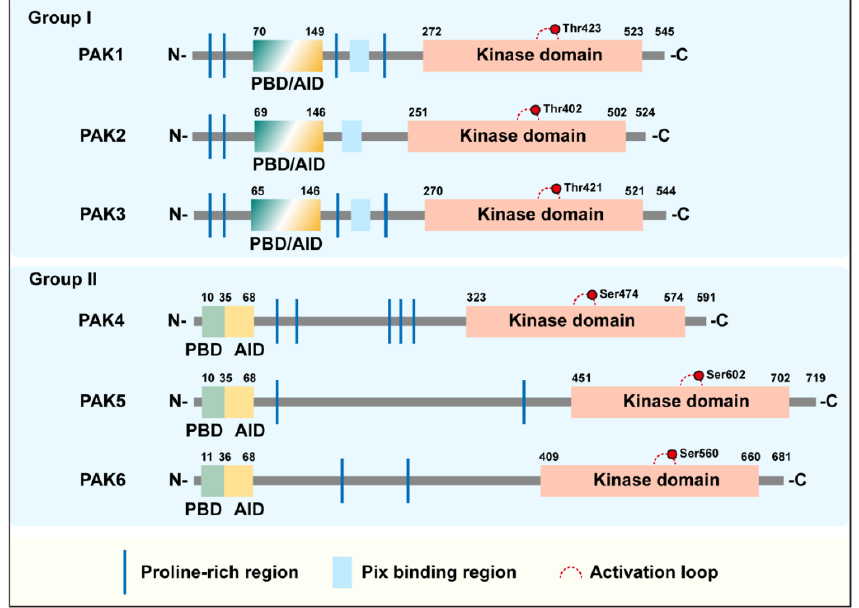
Figure 1. Structural organization of group I/II PAKs. All PAKs contain conserved PBD and ser- ine/threonine kinase domains. Group I PAKs contain the classical AID, which partially overlaps the PBD, in addition to the Pix-binding region, whereas group II PAKs contain AID-like PS structures. The vast majority of PAKs contain proline-rich regions.